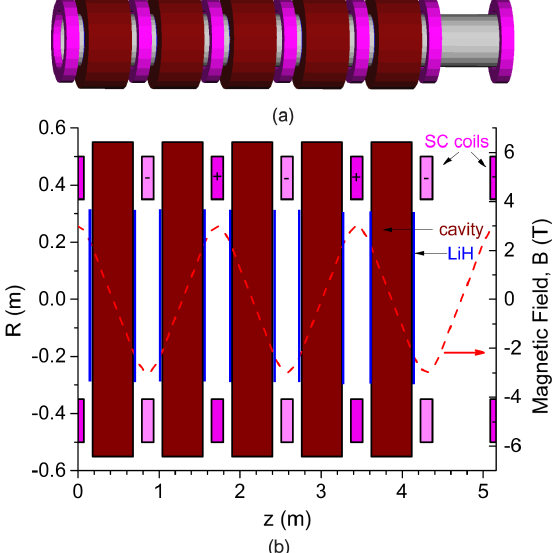
FIG. 1. Schematic representation of the baseline lattice: (a) Con- figuration in 3D; (b) side view. Note that six cells are shown. The magenta cylinders are solenoids, the red cylinders are the active volume of the rf cavities, and the blue blocks are lithium hydride (LiH) absorbers. The dashed red line shows the magnetic field along the axis. The current density of each coil is 105 . 6 A = mm 2 .